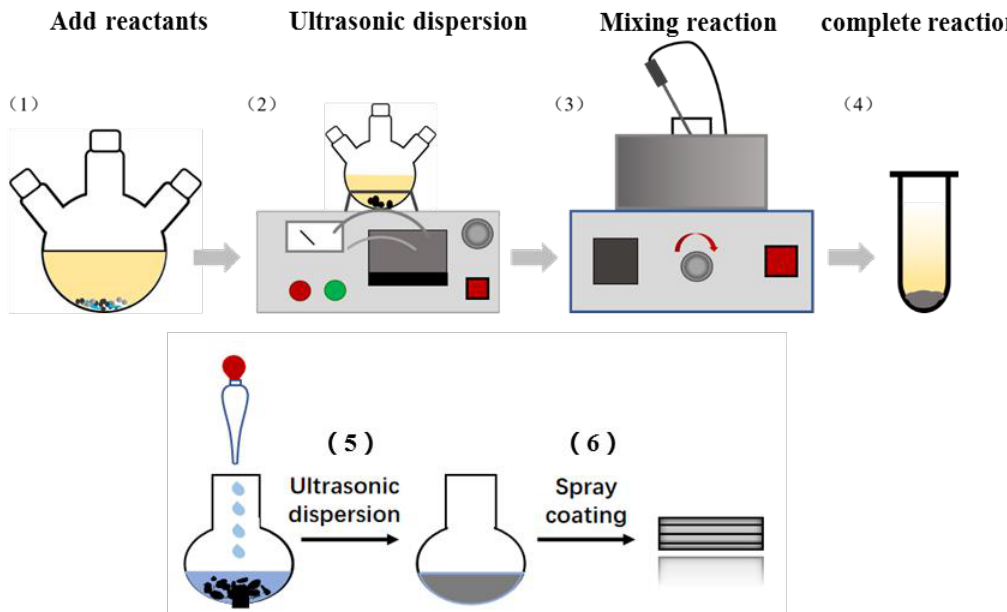
Figure 1. Process schematic diagram of the preparation procedures of the GZC antibacterial coating on the ultrafine glass fiber.